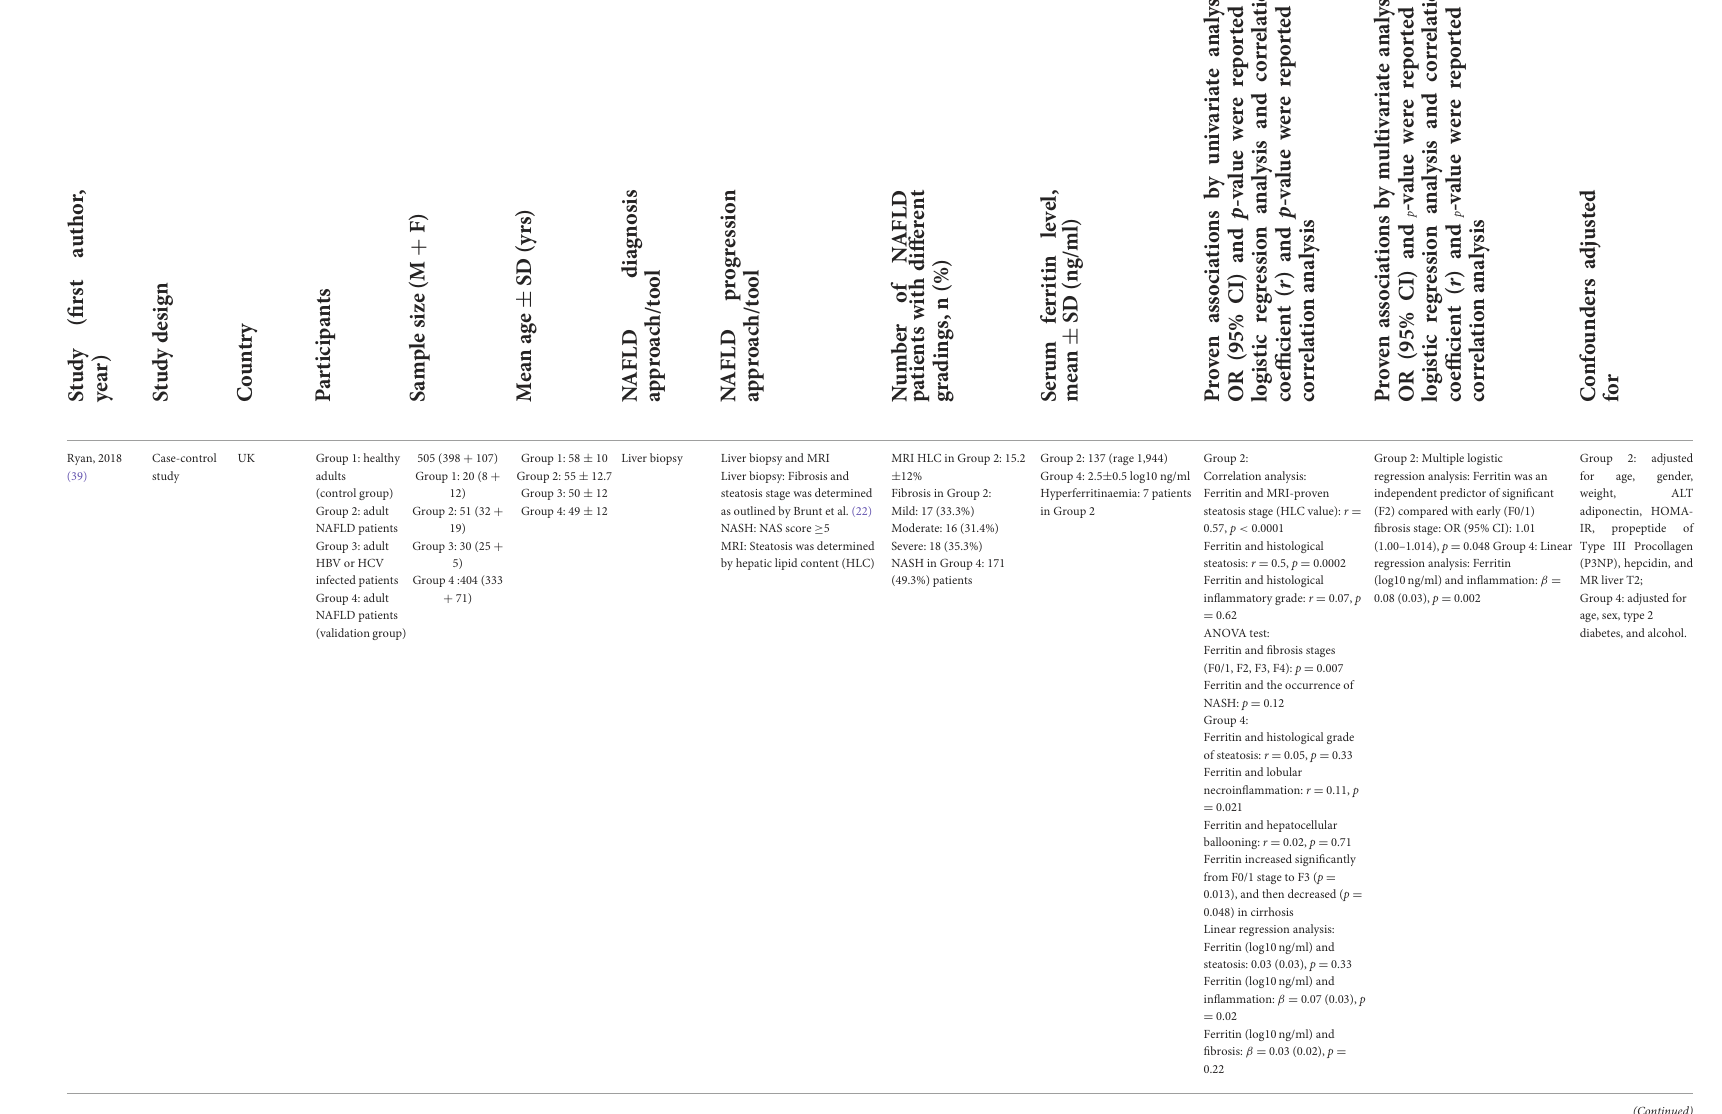
(F0/1,F2,F3,F4): p = 0.007 Ferritinandtheoccurrenceof NASH: p = 0.12 Group4: Ferritinandhistologicalgrade ofsteatosis: r = 0.05, p = 0.33 Ferritinandlobular necroinflammation: r = 0.11, p = 0.021 Ferritinandhepatocellular ballooning: r = 0.02, p = 0.71 Ferritinincreasedsignificantly fromF0/1stagetoF3( p = 0.013),andthendecreased( p = 0.048)incirrhosis Linearregressionanalysis: Ferritin(log10ng/ml)and steatosis:0.03(0.03), p = 0.33 Ferritin(log10ng/ml)and inflammation: β = 0.07(0.03), p = 0.02 Ferritin(log10ng/ml)and fibrosis: β = 0.03(0.02), p = 0.22